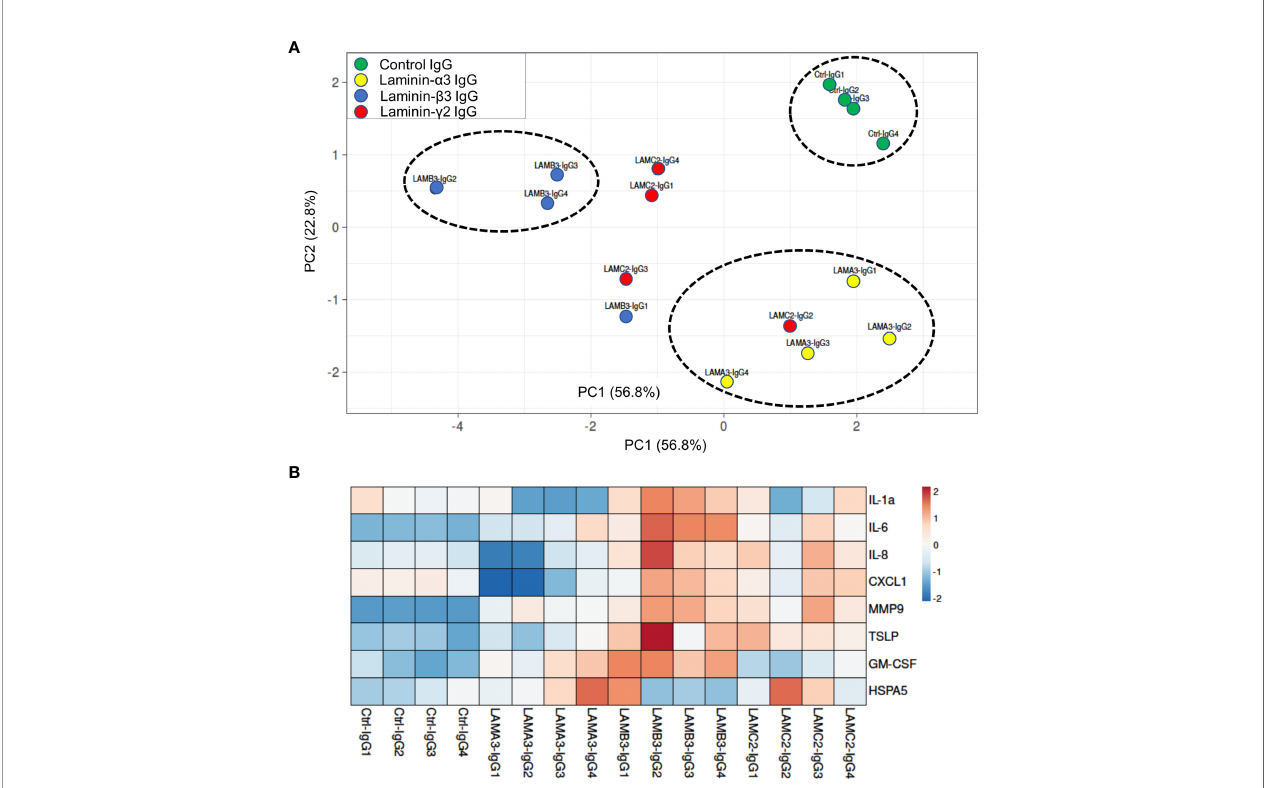
FIGURE 4 | (A) Principal component analysis of supernatant protein concentrations spatially represents control IgG versus each laminin subunit, with greatest distinction between laminin b 3 autoreactivity and control IgG. Only samples with protein levels for all markers were included in PCA. (B) Normalized concentrations of supernatant proteins presented as a heat map demonstrate upregulation of in fl ammatory markers in laminin b 3-IgG treated keratinocytes followed by laminin g 2-IgG treated